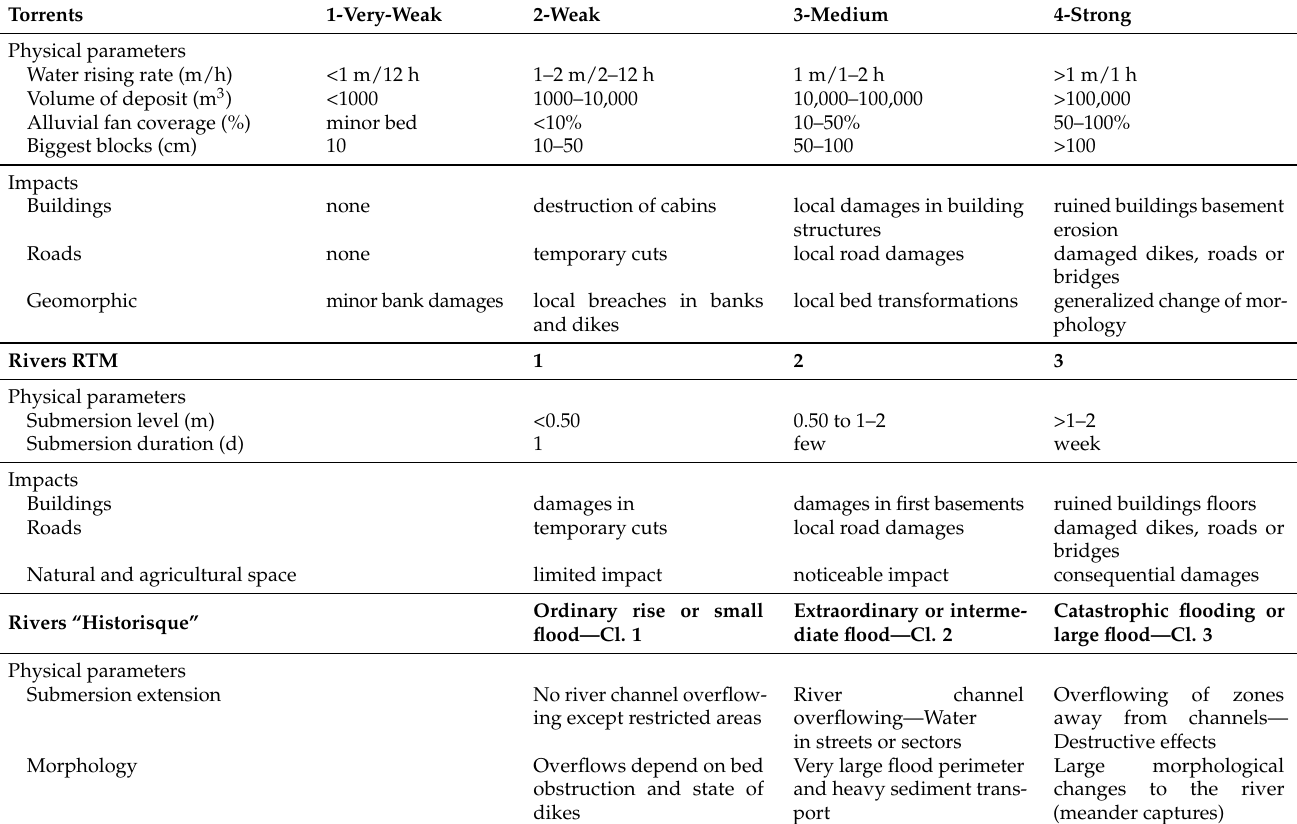
Table 2. Description of the four classes of torrential flood intensity and of the three levels of riverine flooding defined for the RTM database as well as river flooding classes defined for the Historisque database